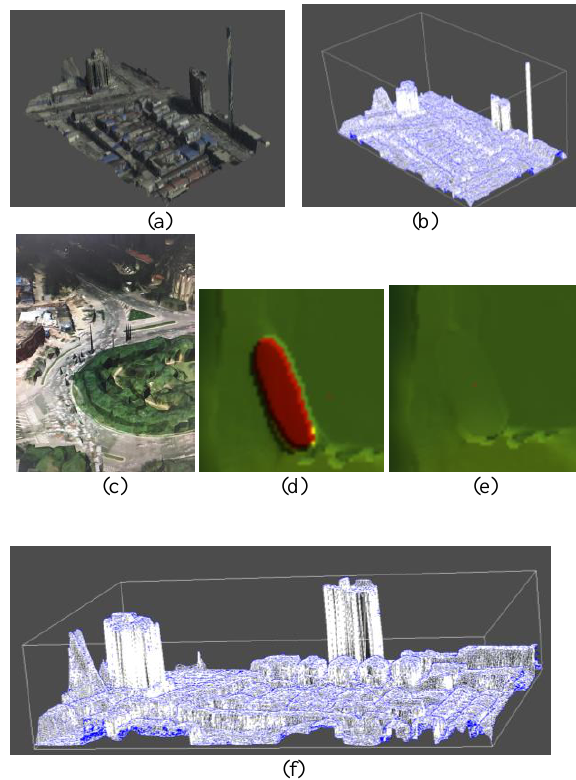
Figure 3. Elevation anomaly elimination by setting the threshold of slope and elevation, and abandoning the edge of the block on both DSM and 3D model. (a) the 3D scene model before editing; (b) the corresponding DSM before editing; (c) the mismatching on the road caused by the moving vehicles mismatching; (d) and (e) the anomaly elimination by threshold of elevation and slope on DSM; (f) the edited DSM